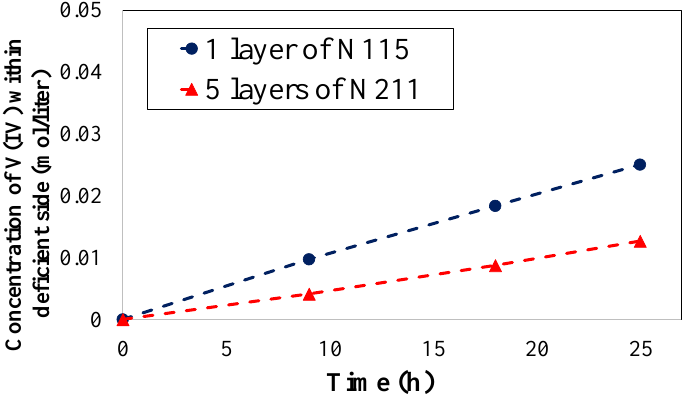
Figure 11. Comparison of concentration-gradient-induced crossover between 5 layers of NR211 and 1 layer of N115.